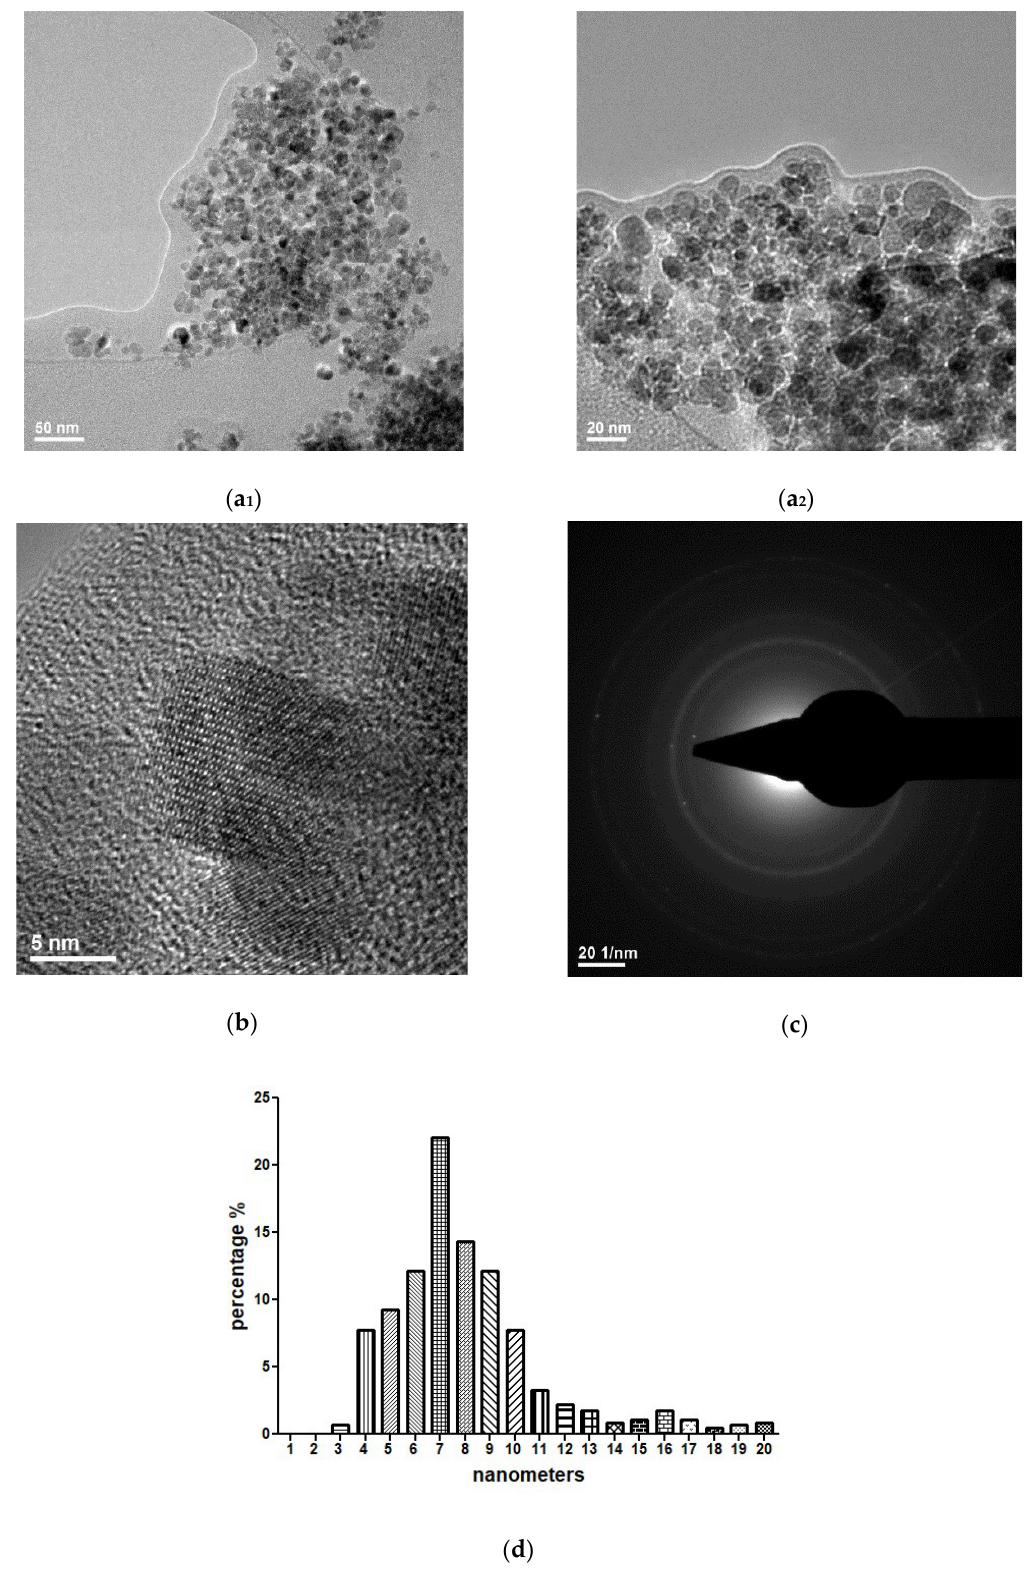
Figure 2. Transmission electron microscopy (TEM) = ( a 1 ,a 2 ) and HR-TEM = ( b ) images and selected area electron diffraction (SAED) pattern ( c ) of Fe 3 O 4 @CEF powdery sample. Figure ( d ) reveals the percentage of nanoparticle size in the analysed samples.